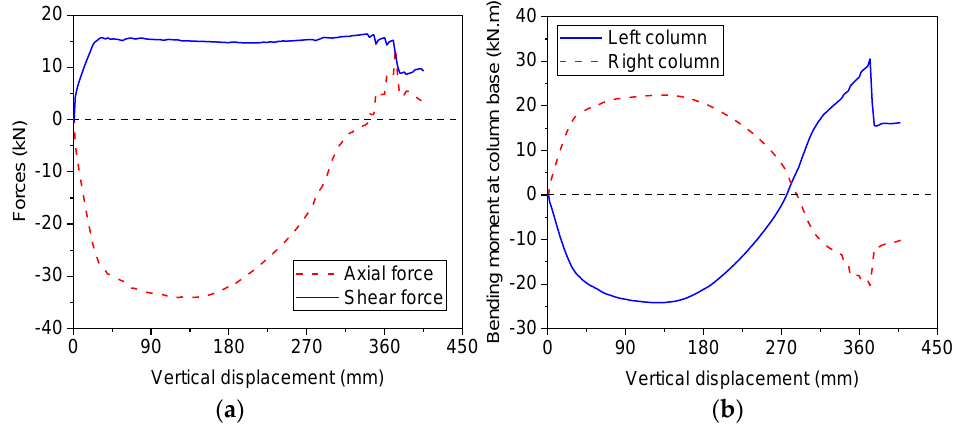
Figure 9. Comparisons between experimental and numerical results of single-storey frame: ( a ) axial and shear force; ( b ) bending moment.